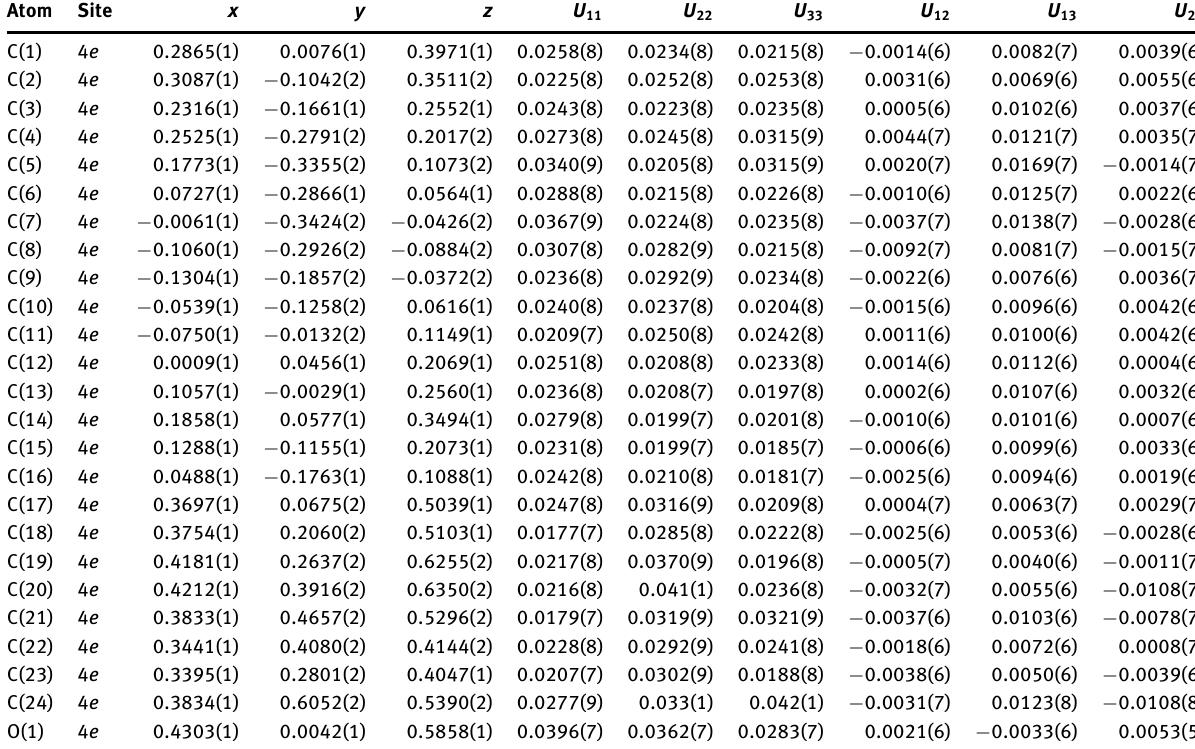
Table 3: Fractional coordinates and atomic displacement parameters (Å 2